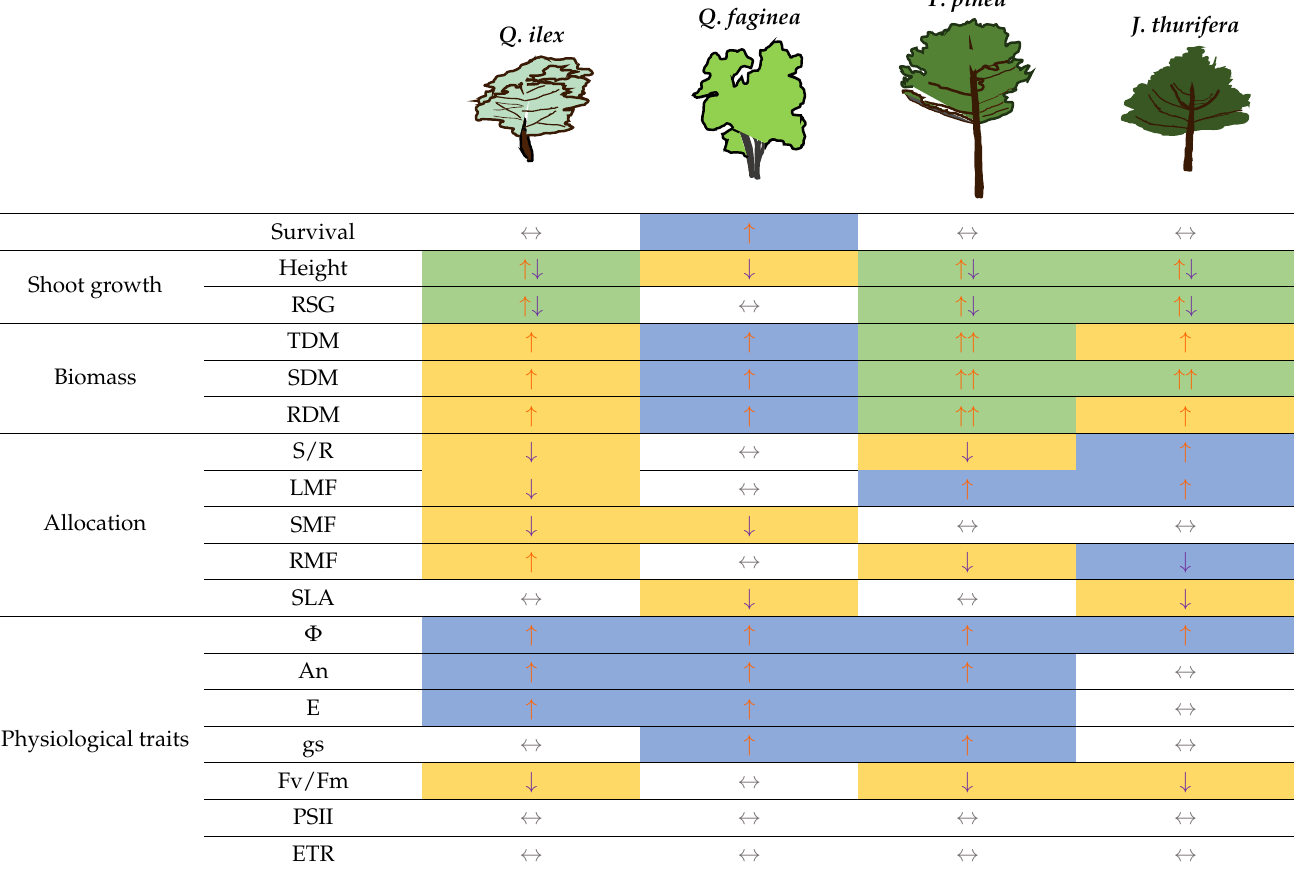
Q. ilex Q. ilex Q. ilex